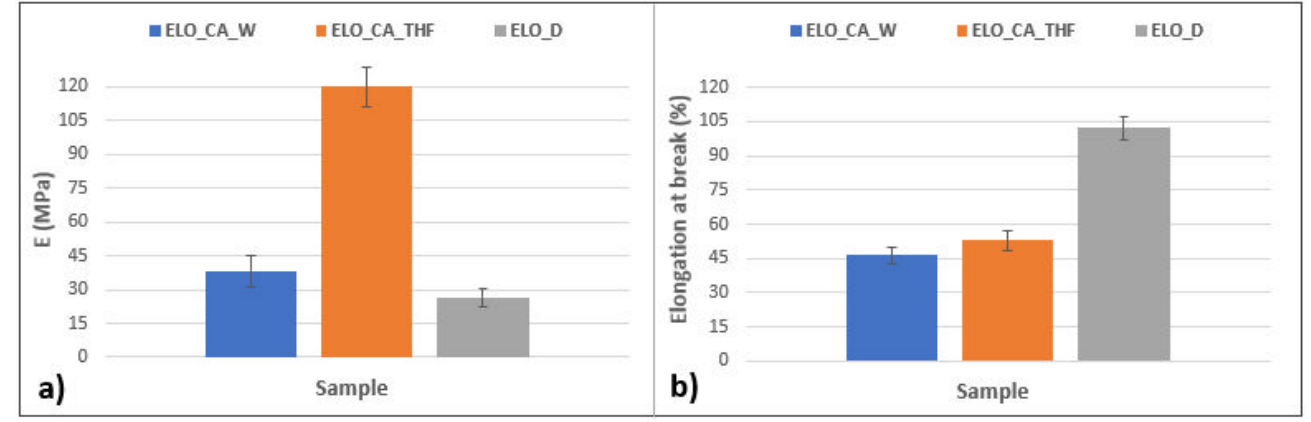
Figure 8. Mechanical test results for the ELO ‐ based polymeric networks: ( a ) Young modulus (MPa), ( b ) elongation at break (%).